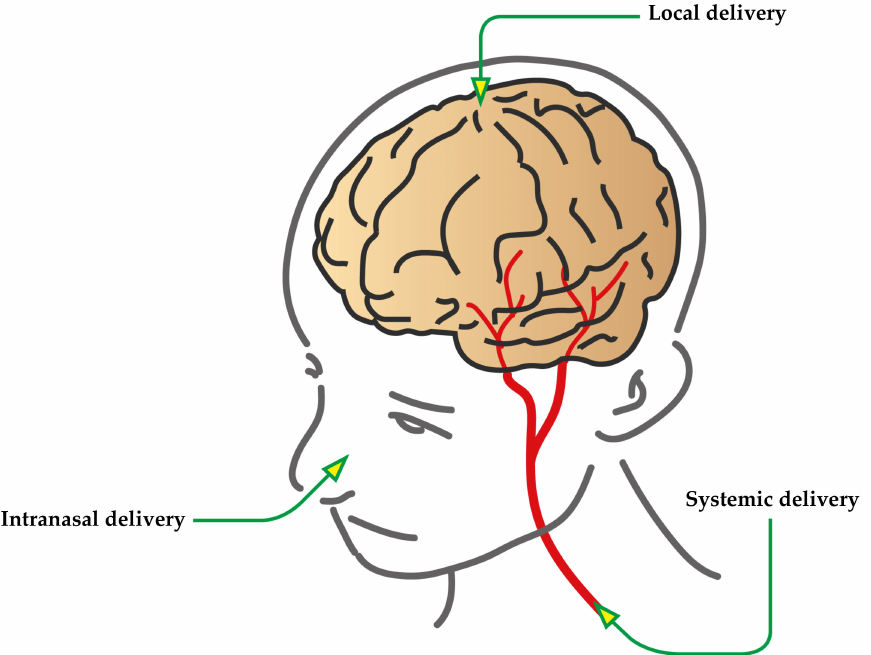
Figure 2. Different brain delivery strategies showing the major routes: local delivery, intranasal delivery, and systemic